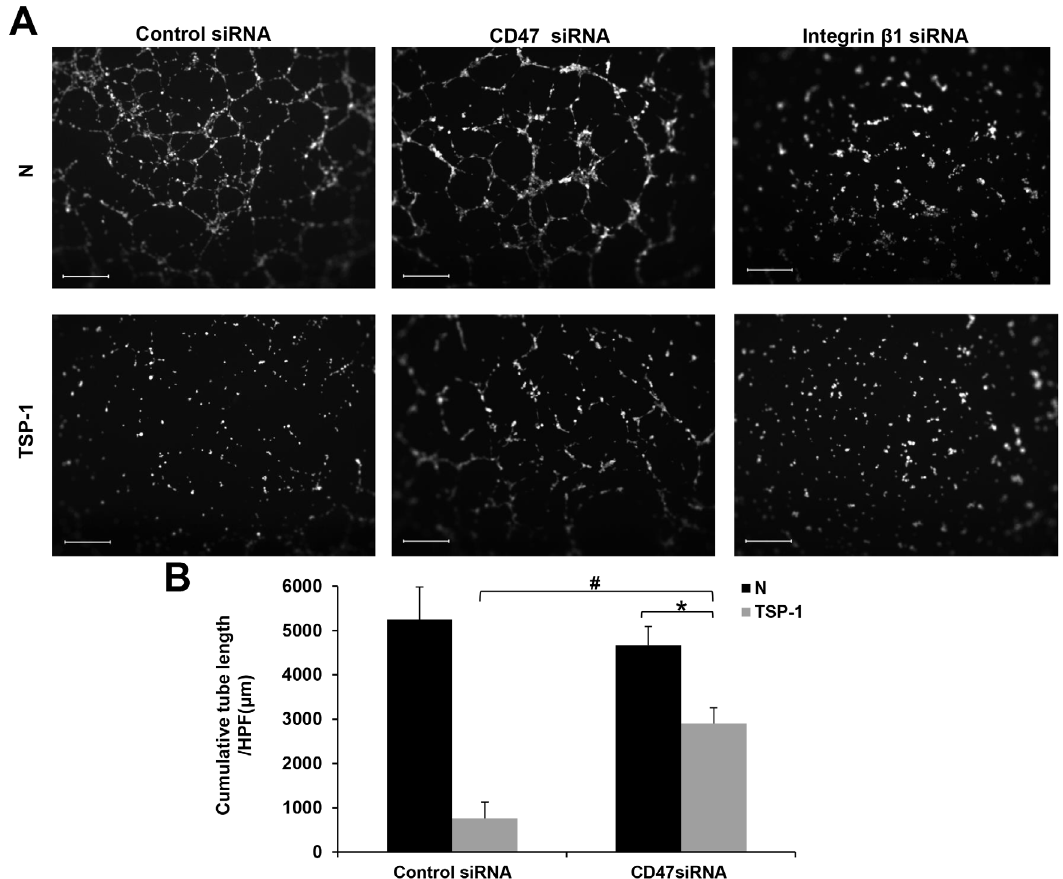
Figure 4. Silencing of CD47 attenuated TSP-1 9 s inhibition on angiogenesis of late EPCs. (A) Late EPCs were transfected with negative control siRNA, CD47 siRNA or integrin b 1 siRNA, and then plated on Matrigel in the presence or absence of TSP-1(2 m g/ml) as described in methods. EPCs images were captured and analyzed by Leica Qwin system (Scale bar=400 m m, 50 6 magnification). (B)Total tube length per HPF (100 6 magnification) was measured. Values are presented as the mean 6 S.D. of three independent experiments ( # p , 0.01 versus control siRNA with TSP-1 stimulation,* p , 0.01 versus CD47 siRNA without intervention).